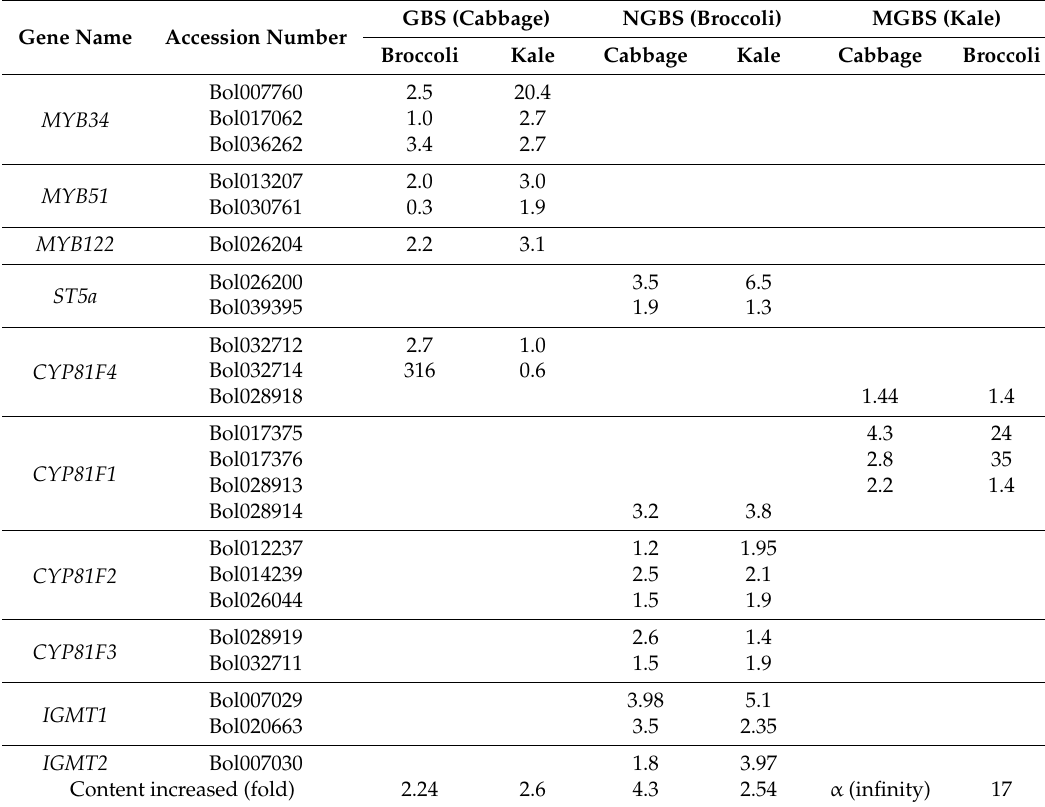
Table 4. Upregulation of indolic glucosinolate transcription factor and biosynthesis genes in one subspecies compared to other two subspecies for the control